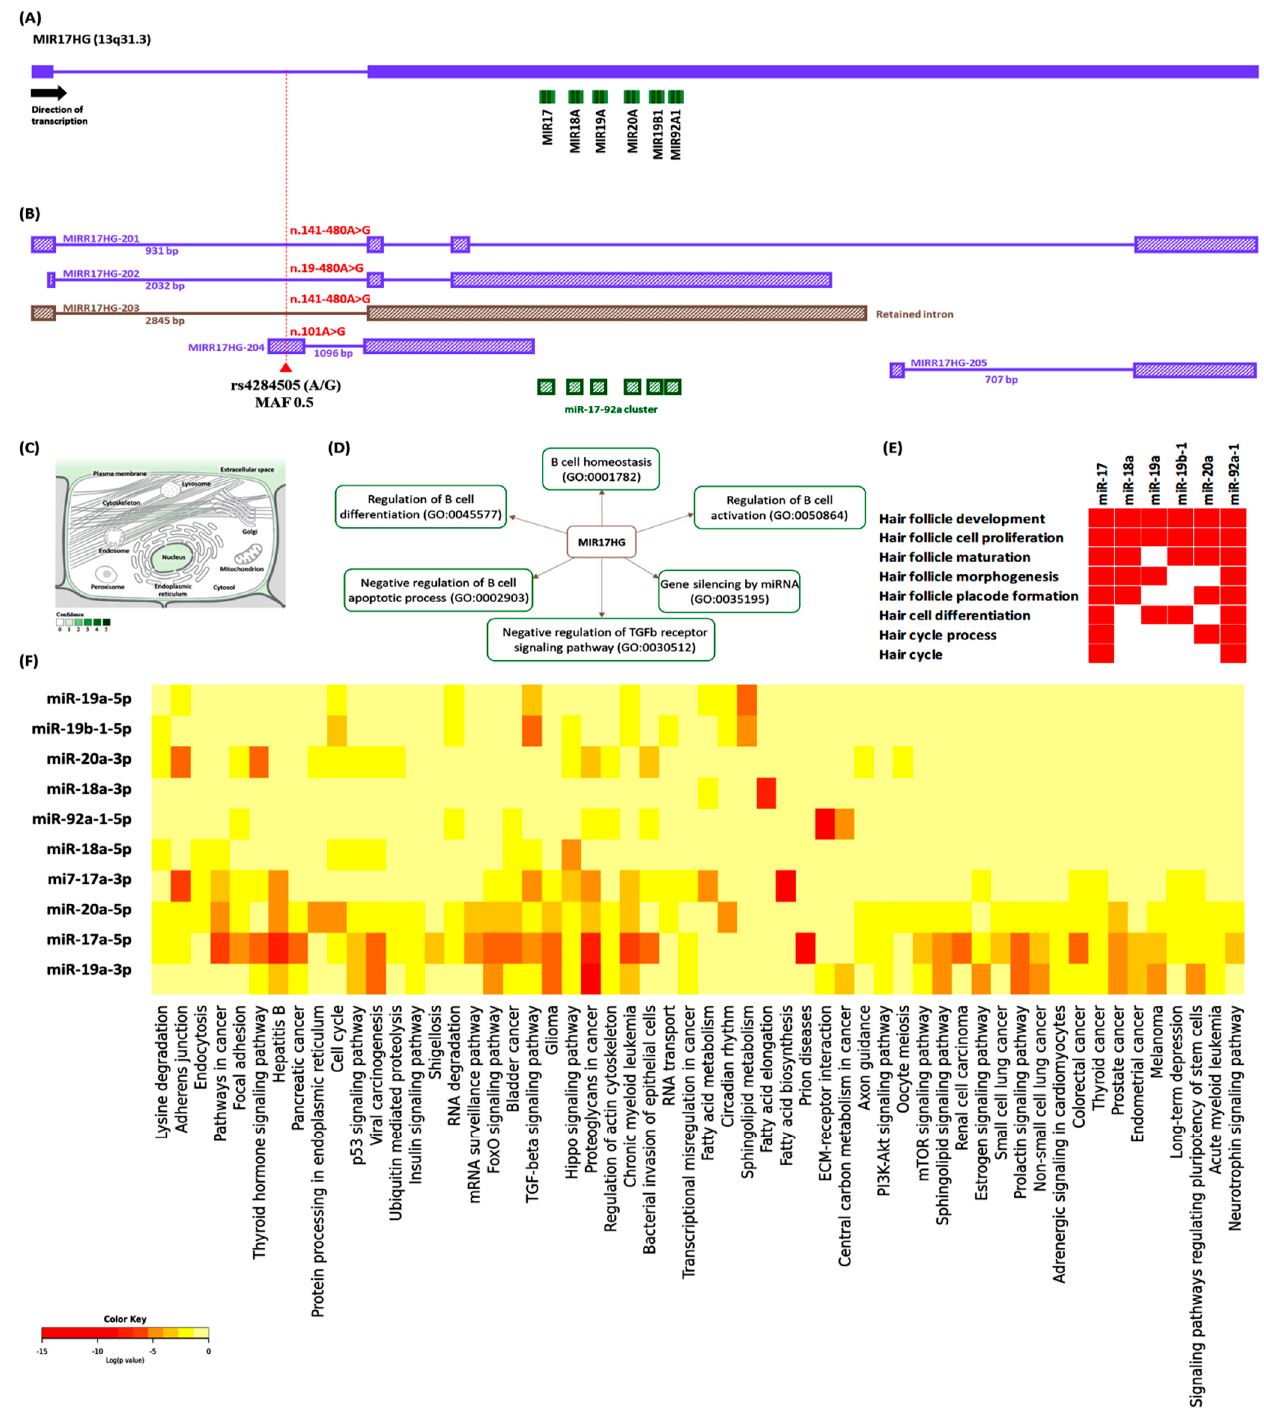
Figure 1. Structural and functional analysis of the MIR17HG cluster region. ( A ) Genomic context of the MIR17 host gene. The MIR17HG cluster gene is located at chromosome 13q31.3 at the forward strand. The genomic sequence enclosed six microRNAs with the following order: miR-17, 18A, 19A, 20A, 19B1, and 92A1. ( B ) MIR17HG transcripts and polymorphism. The gene encodes four lncRNAs and one retained intron transcript by alternative splicing, but only the longest (MIR17HG-202) is a polycistronic transcript containing the miR-17-92a-1 cluster. A common variant, rs4284505, caused by A with G substitution with a minor allele frequency of 0.5 was analyzed in the study. It was overlapped with four MIR17HG transcripts: within the first intron of three of them (480 bases upstream to the start of the second exon) and as a non-coding exon SNP in another one at nucleotide number 101 out of 1096 of the first exon. ( C ) Subcellular localization of MIR17HG within the nucleus